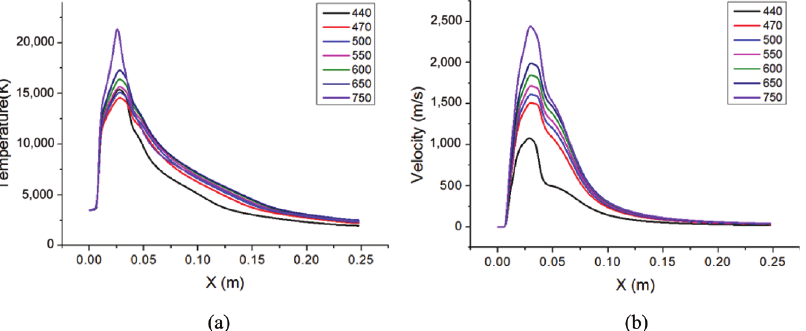
Figure 8: Effect of current on plasma jet (a) temperature and (b) velocity distribu- tion along the axial of plasma jet with initial total gas flow rate of 70 L/min and a constant H 2 /(Ar þ H 2 ) ratio of